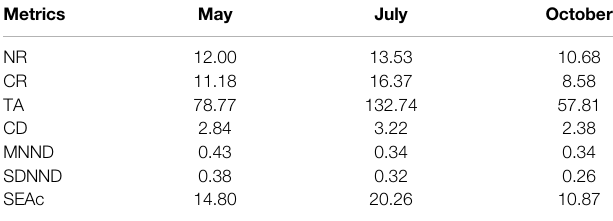
TABLE 3 | Metrics for communities comprised of cray fi sh, snails, prawns and fi shes during May, July and October, 2019. NR, nitrogen range; CR, carbon range; TA, total area of convex hull; CD, mean distance to centroid; MNND, mean nearest neighbor distance; SDNND, standard deviation of the nearest neighbor distance; SEAc, the core isotopic niche area of the community ( ‰ 2 ).